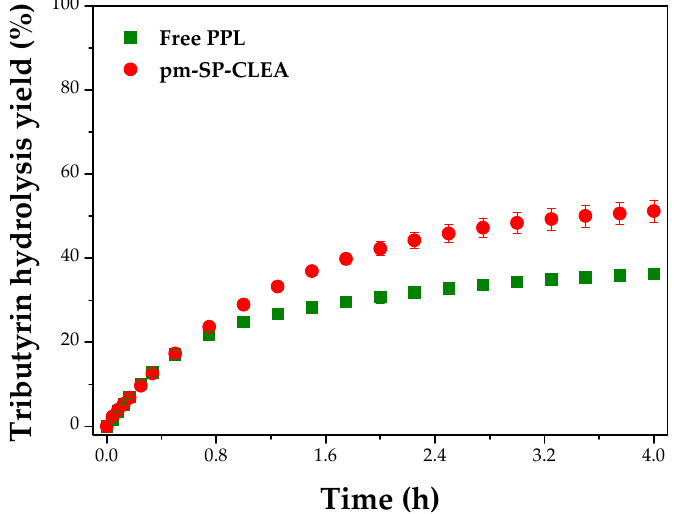
Figure 12. Yield of the hydrolysis of tributyrin with the reaction time at 37 °C and pH 7.5 stirred at 500 rpm catalyzed by free PPL and pm-SP-CLEA (74.22 mM tributyrin and 70 TBU/g tributyrin). Yield was calculated as percentage of butyric acid released (in µ moles) in relation to the total theoretical value.